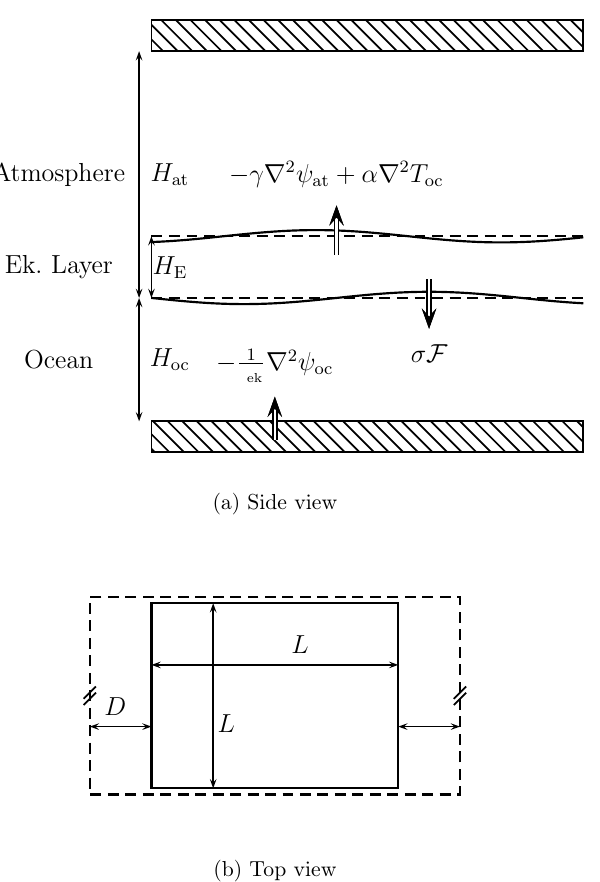
Fig. 1. Schematic model diagram. (a) Model cross-section; here ψ at is the atmospheric stream function, ψ oc is the oceanic stream function, and T oc is the sea surface temperature (SST) field. The arrows mark a potential vorticity (PV) flux; see text for the definition of the other parameters. (b) Top view of the model, in which the solid box represents the contours of the oceanic basin, while the dashed box delimits the contours of the atmospheric β -channel; this channel extends to the east and west of the oceanic basin.